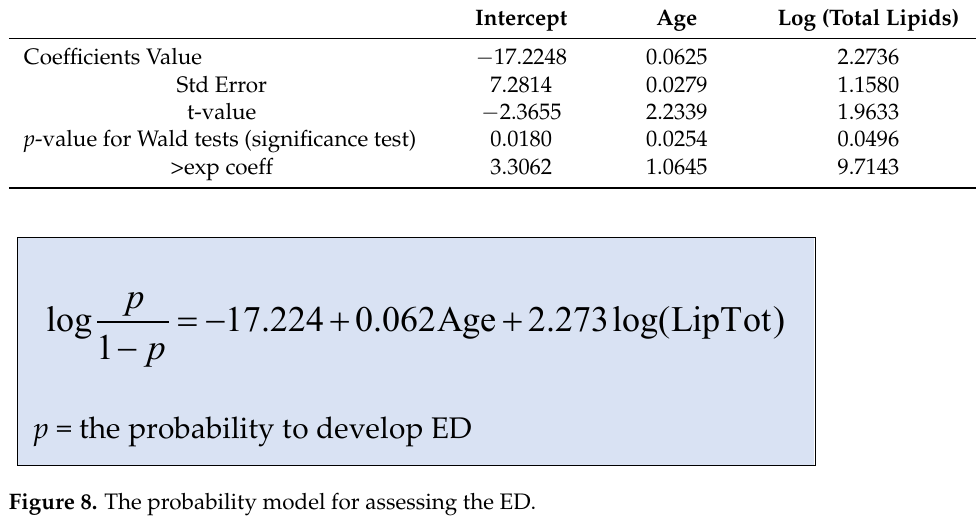
Figure 9. The probabilities to develop ED for all patients included related to age and total lipids. 4. Discussion Starting from our own experience and clinical evidence from the specialized litera- ture, confirming that men with HIV suffer from sexual disorders more often than age - matched, healthy controls [8–10,18], we tried to evaluate this aspect in our population and also to identify some associated factors that can influence erectile function enough to al- low the design of a statistical model that can permit the evaluation of the risk of develop- ing ED for HIV-positive men. Our study was able to demonstrate the correlation between the serum level of total lipids and the chances of developing ED. Age is also a known factor when it comes to evaluating the deterioration of erections. In the era of personalized medicine, our paper offers the clinician a tool able to calculate exactly the probability to develop ED for an HIV-infected male. Analyzing the data presented in the specialized literature, there is a large number of authors who conclude the importance of age, dyslipidemia, diabetes, and smoking or drug use for erectile function impairment in the case of HIV-positive men [19–25]. On the other hand, it was also demonstrated that these factors can also be a cause of concern for